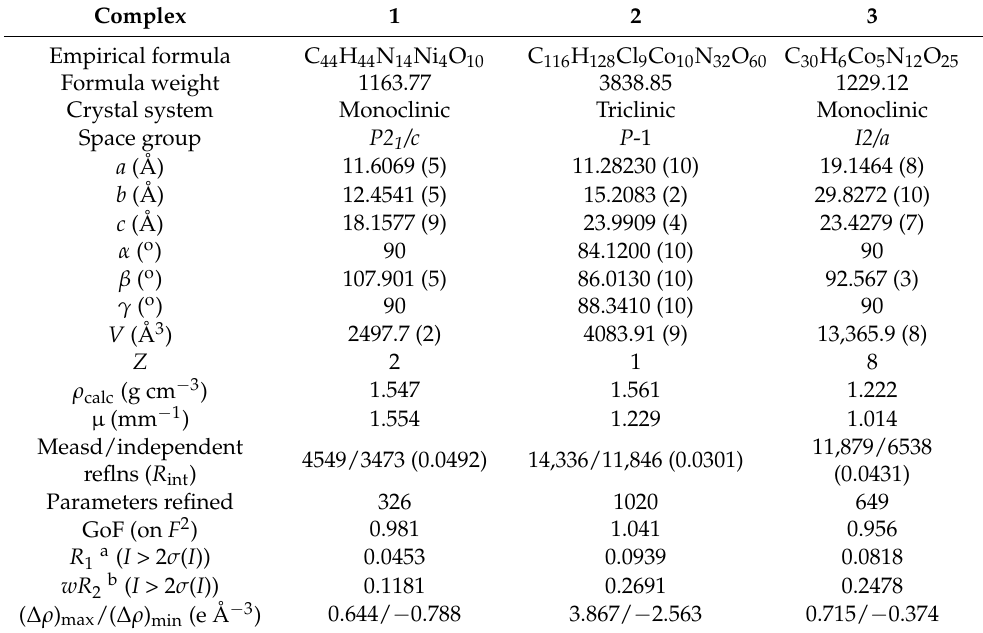
Table 1. Crystallographic data for complexes 1–3